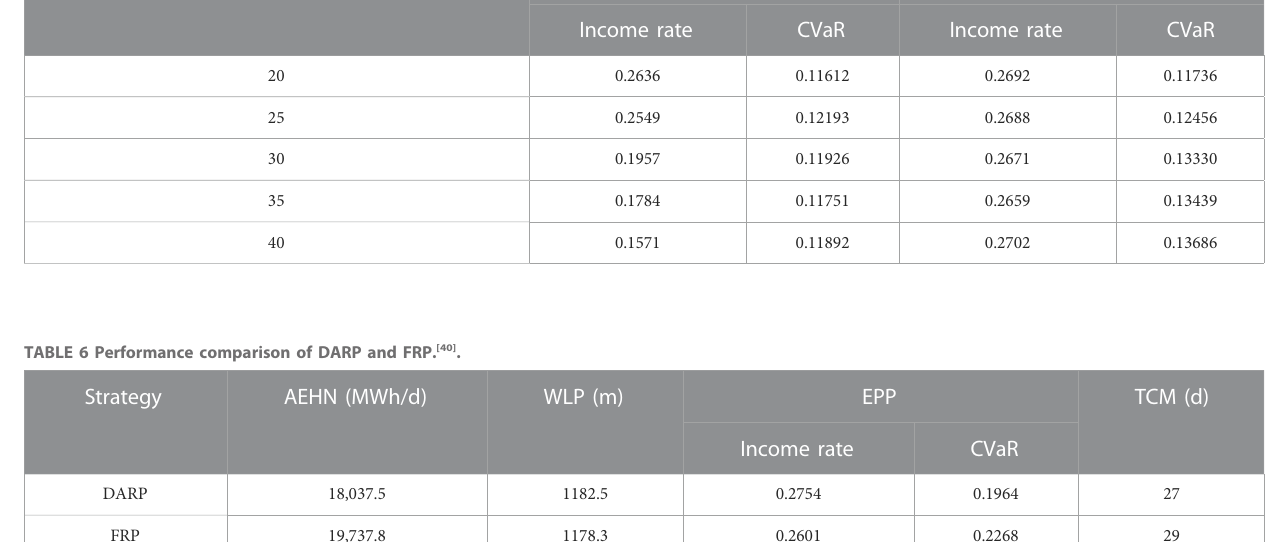
TABLE 5 Performance comparison of Risk measurement methods. Proportion of new energy generation (%)